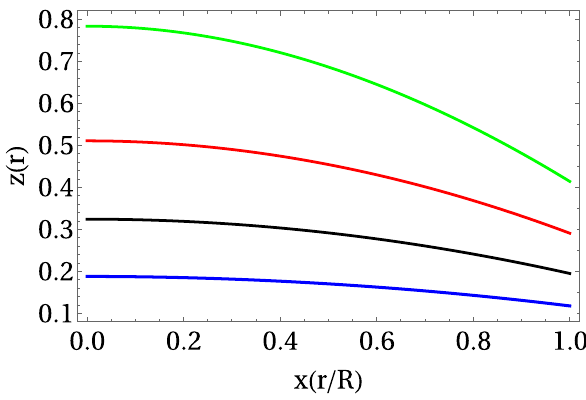
Fig. 2 Radial metric for Model I for compact factors: 0.1 (blue line), 0.15 (black line), 0.20 (red line) and 0.25 (green line)